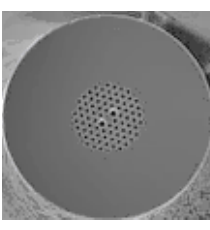
Figure 6. Photo of the Hi-Bi PCF